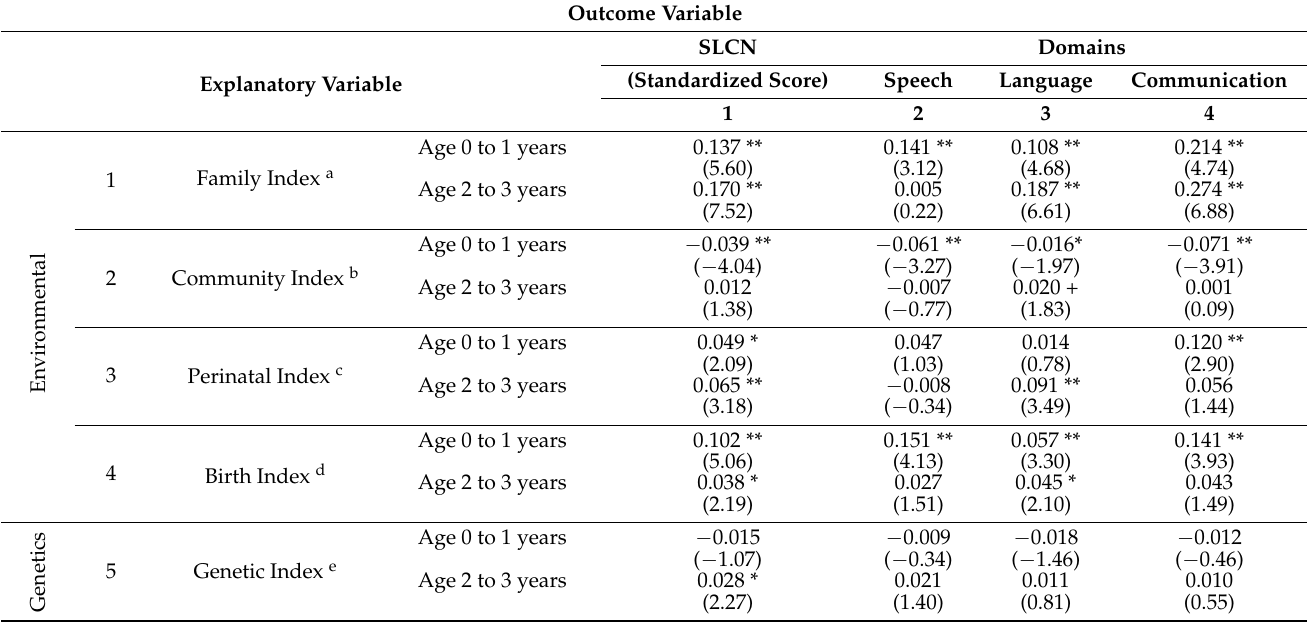
Table 4. Interactions with age of child